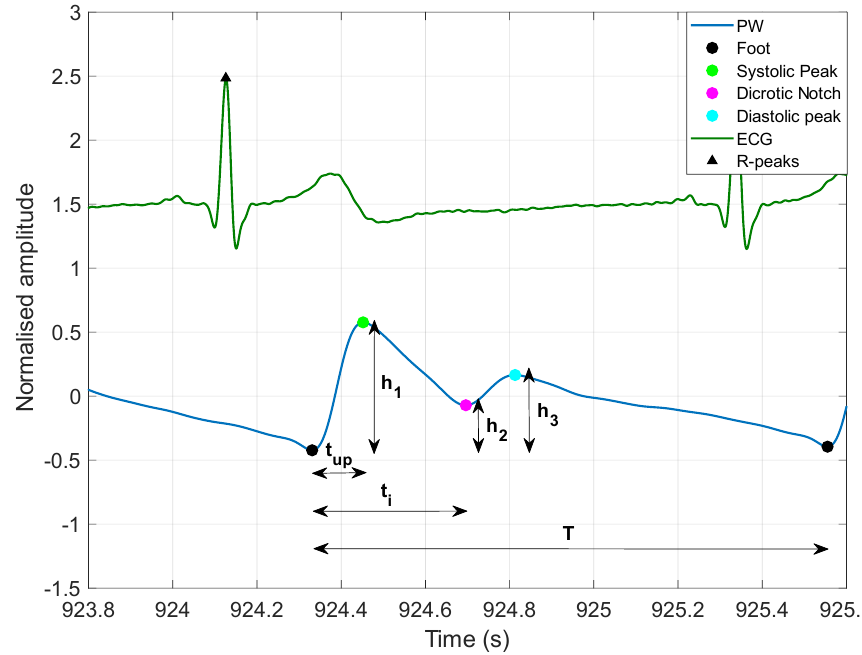
Figure 2. Graphical example of PW fiducial points and morphological parameters.